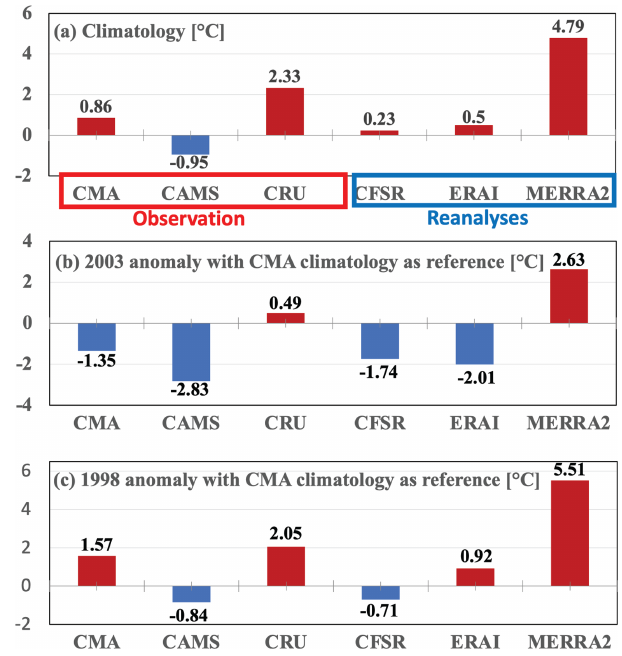
Figure 4. May T -2m over the Tibetan Plateau above 4000m from observational and reanalysis data sets; (a) mean climatology, (b) 2003 anomaly (a cold May) and (c) 1998 anomaly (a warm May). Note. The CMA climatology is used as a reference for the anomalies. Because each T -2m data set has its own elevation, all the data have been adjusted to the CMA elevation for